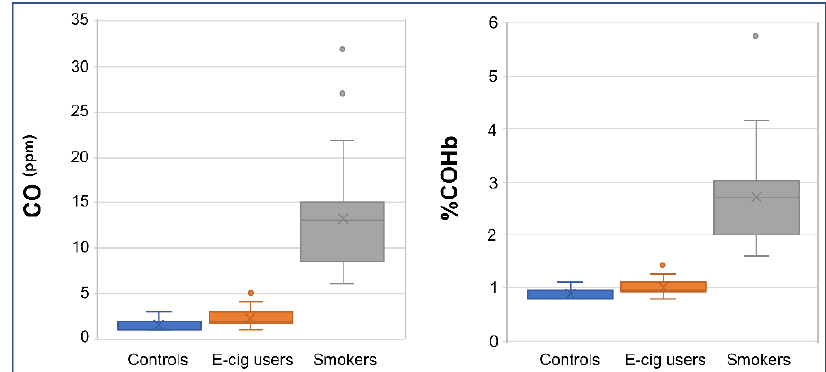
Figure 7. Validation of smoking/vaping status. Exhaled breath was measured in e-cig users, smokers, and controls ( n = 18, 25, and 30, respectively) by a Bedfont Micro +TM Smokerlyzer ® Breath CO monitor according to the instructions of the manufacturer (Bedfont Scientific Ltd., Kent, UK). Whisker box plots display distributions of carbon monoxide (CO) levels (parts per million, ppm) and percentage of carboxyhemoglobin (%COHb) in the respective groups. Table 1. Characteristics of the study population.